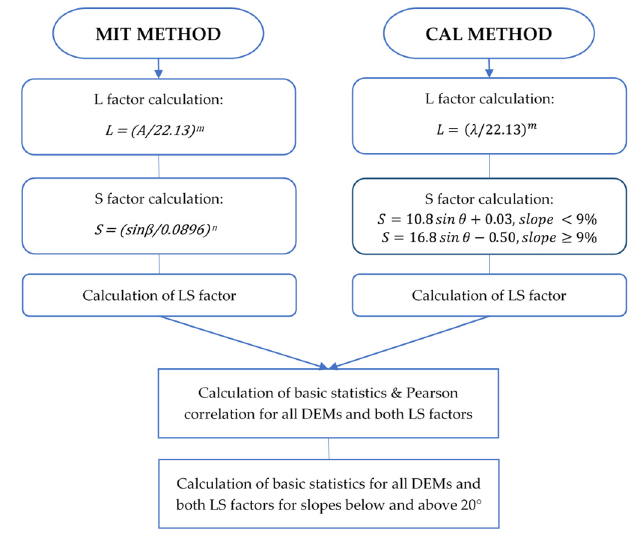
Figure 8. Methodology of LS factor calculations using two different approaches and comparison of their obtained values.